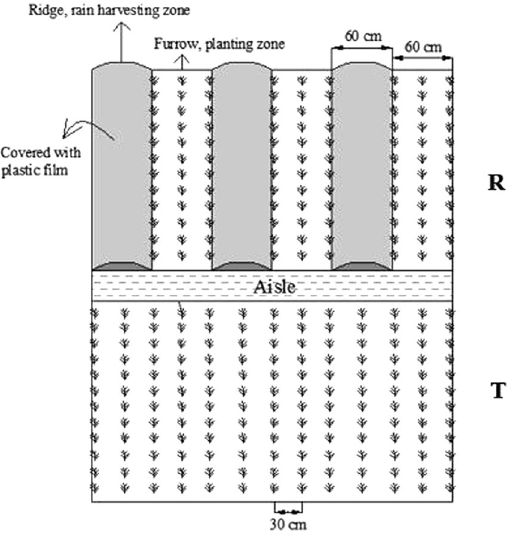
Figure 6. Layout of the field experiments with two planting patterns during the 2013–2015 foxtail millet growing seasons. Note: R = ridge and furrow rainfall harvesting planting; T = traditional flat